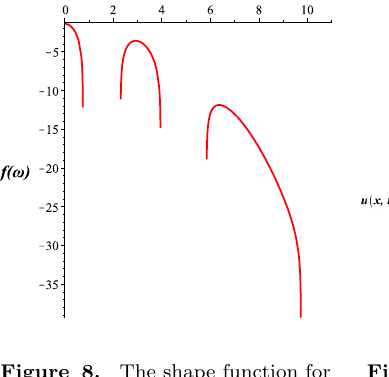
Figure 8. The shape function for the white noise for parameter set a = λ = ν = 1 = c 1 = c 2 = 1.